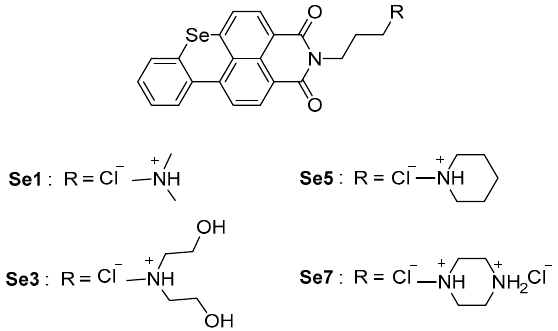
Figure 14. Chemical structures of Benzoselenoxanthene analogues, TMPRSS2 G-quadruplex stabilizers.